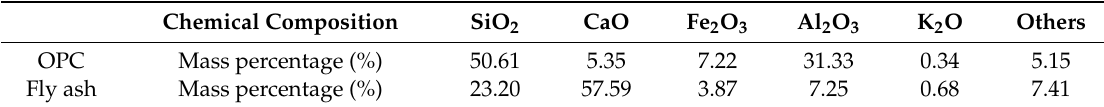
Table 3. Chemical compositions of OPC and fly ash.